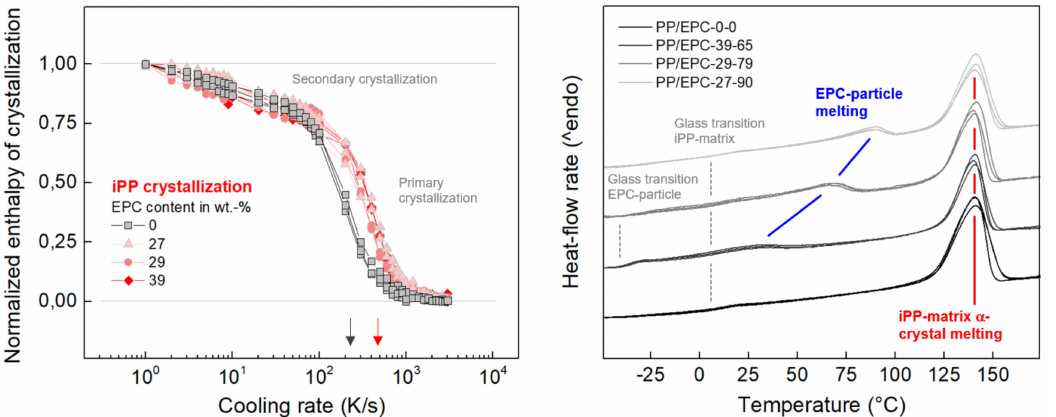
Figure 4. Normalized enthalpy of crystallization of neat iPP (gray squares) and of the iPP-matrix in heterophasic iPP (red symbols) as a function of the cooling rate ( left ). FSC heating scans of neat and heterophasic iPP ( right ). The heating rate is 1000 K / s, and the rate of prior cooling is 1 K /